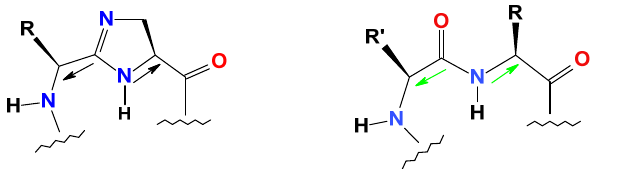
Figure 1. Comparison between trans peptide bond structure ( right ) and imidazoline moiety ( left ) as a peptide bond replacement, and which mimics trans geometry irreversibly.